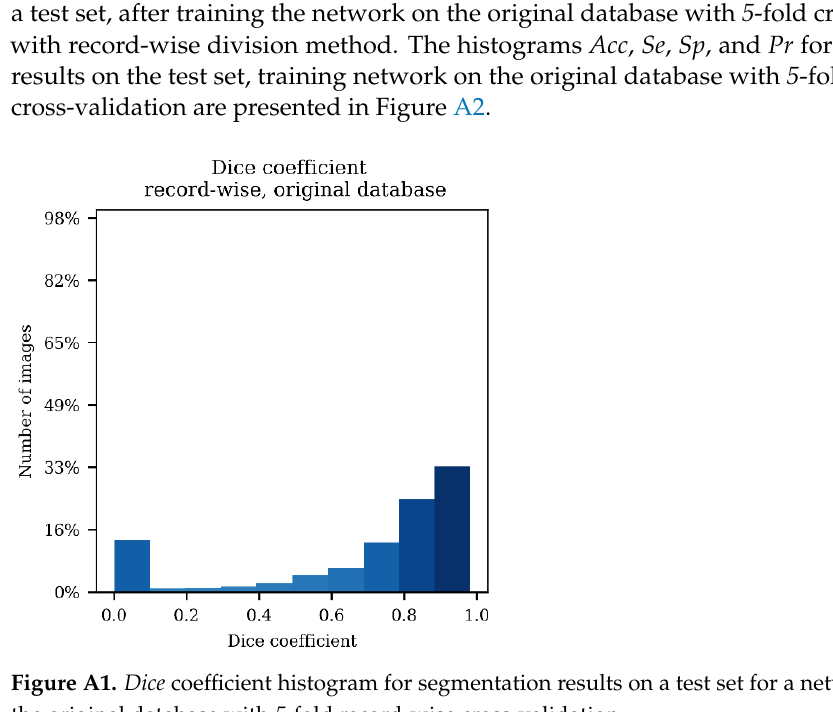
Figure A2. Histograms of metrics for segmentation results on a test set for a network trained on the original database with 5 -fold record-wise cross-validation. Acc — accuracy; Se — sensitivity; Sp — specificity; Pr — precision. The histogram of the Dice coefficient for the segmentation results on the test set, train- ing the network on the augmented database with 5 -fold record-wise cross-validation, is shown in Figure A3.